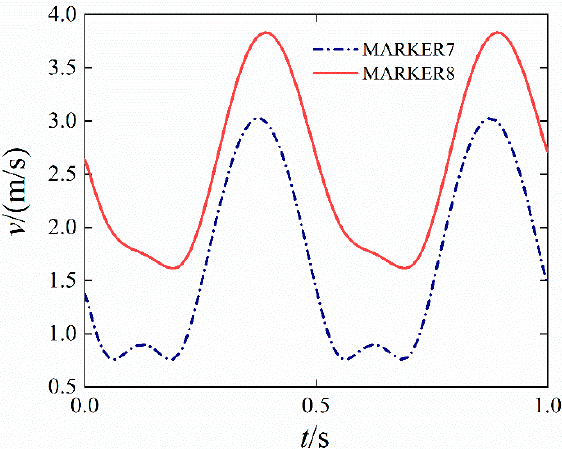
Figure 13. The curve of the linear velocity of the marked point with time.